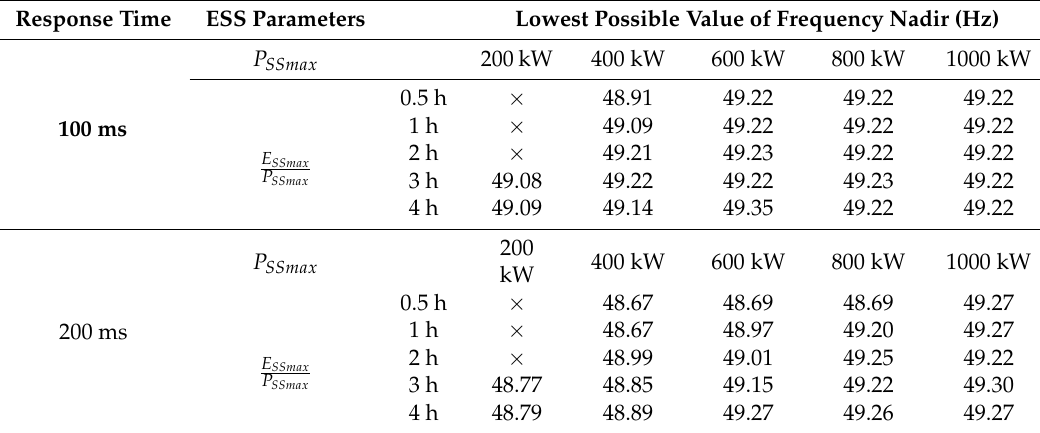
Table 4. Summary of frequency nadir for different ESS sizes and response times.